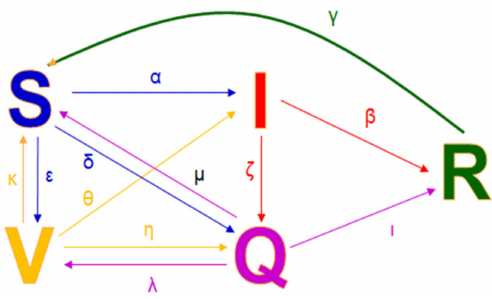
Figure 5. Schematic representation of the CSIRVQ